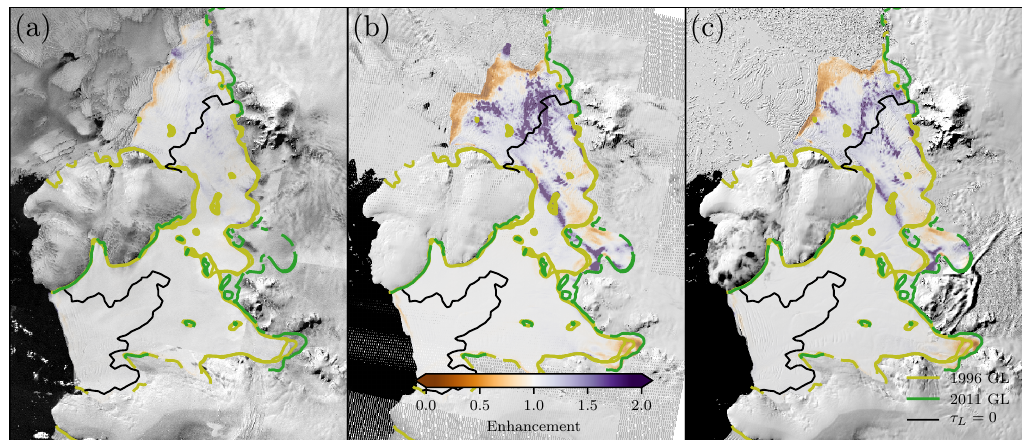
Figure 5. Inferred enhancement to ice flow in (a) 1996, (b) 2010, and (c) 2014. The enhancement factor gives the depth-averaged weakening of the ice relative to that predicted by a temperature model, with values larger than 1.0 indicating weakening. Black line indicates the zero contour of τ L in 1996, i.e., the boundary between the compressive (upstream) and extensional (seaward) regimes. Backgrounds are Landsat images from the same year as the